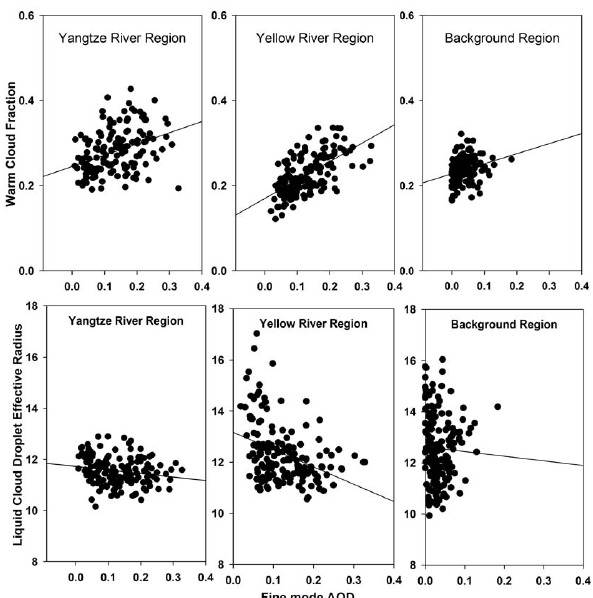
Figure 4. The scatter plots of warm cloud fraction (upper panel) and liquid cloud droplet Fig. 4. The scatter plots of warm cloud fraction (upper panel) and effective radius (lower panel) to the fine mode aerosol optical depth (AOD) over two polluted areas: the Yangtze River Region (30-34ºN, 118-122ºE, left column) and Yellow liquid cloud droplet effective radius (lower panel) to the fine mode River Region (32-36ºN, 111-115ºE, middle column), and one pristine background area aerosol optical depth (AOD) over two polluted areas: the Yangtze (32-36ºN,100-104ºE, right column) . River Region (30–34 ◦ N, 118–122 ◦ E, left column) and Yellow River Region (32–36 ◦ N, 111–115 ◦ E, middle column), and one pristine background area (32–36 ◦ N, 100–104 ◦ E, right column).